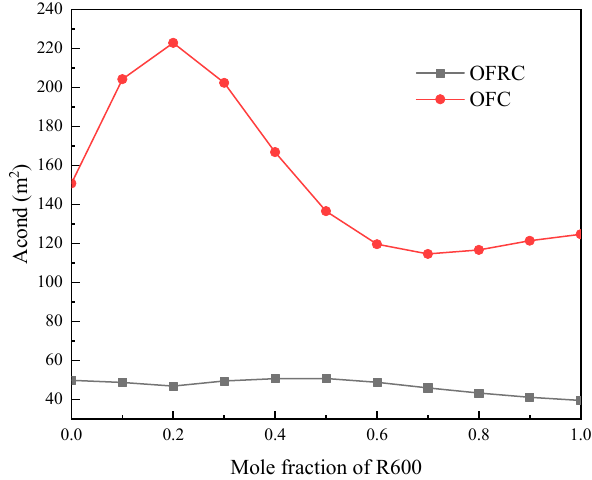
Figure 12. Variation of the heat exchange area of the system condenser with the R600 mole fraction.